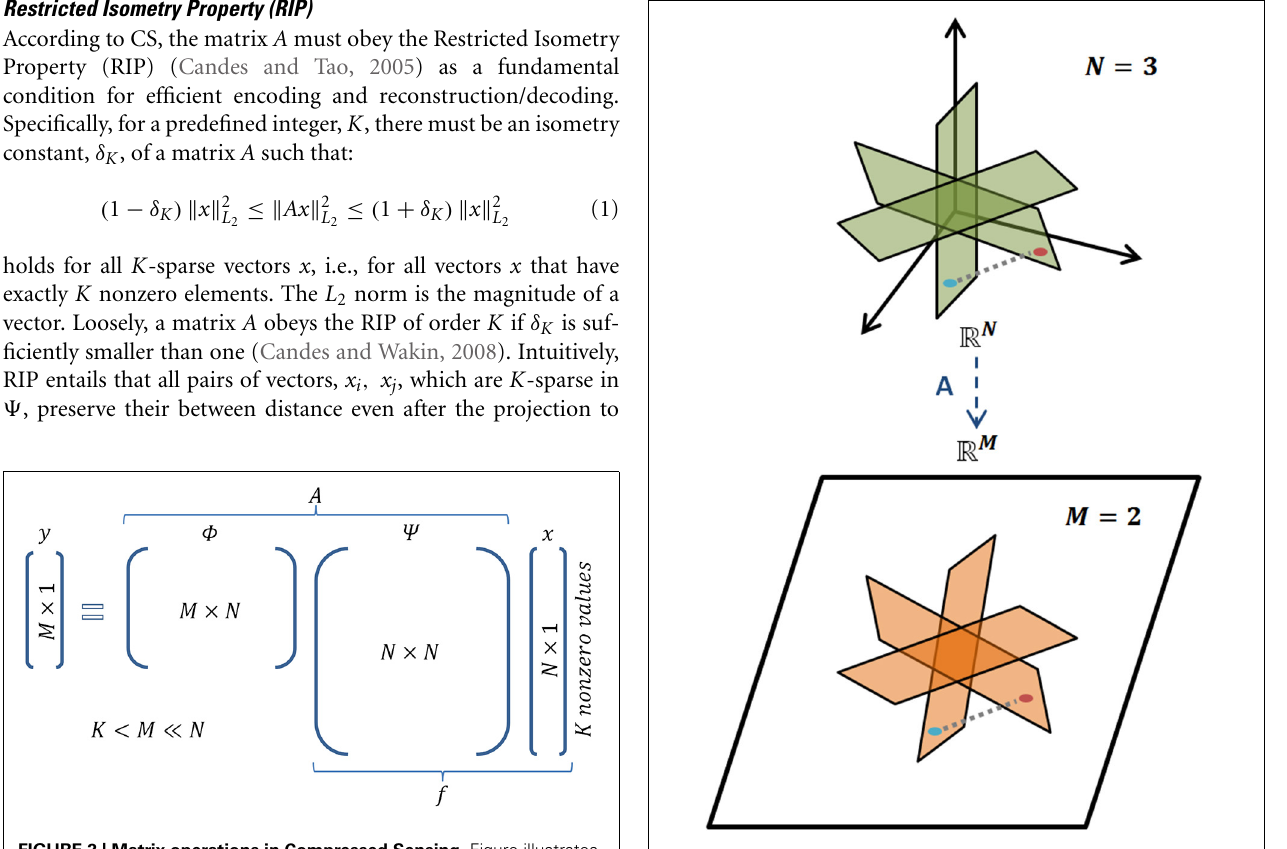
It is actually a combination of the equationis f = (cid:3) x (sparse representation of signal f ) and y = (cid:2) f (sampling of signal f ).